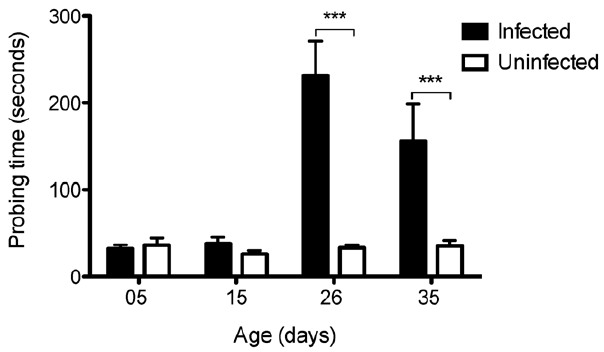
Figure 2. Probing behavior of A.aegypti mosquitoes. Comparison of time spent by mosquitoes infected with Wolbachia (black bars) or tetracycline treated counterparts (white bars) of different ages (5, 15, 26 and 35 days) from the insertion of mouthparts into the skin of a human hand and the first sign of blood within the insect midgut. ( N =12–40 per group). Bars depict means 6 S.E.M. *** p , 0.0001 by